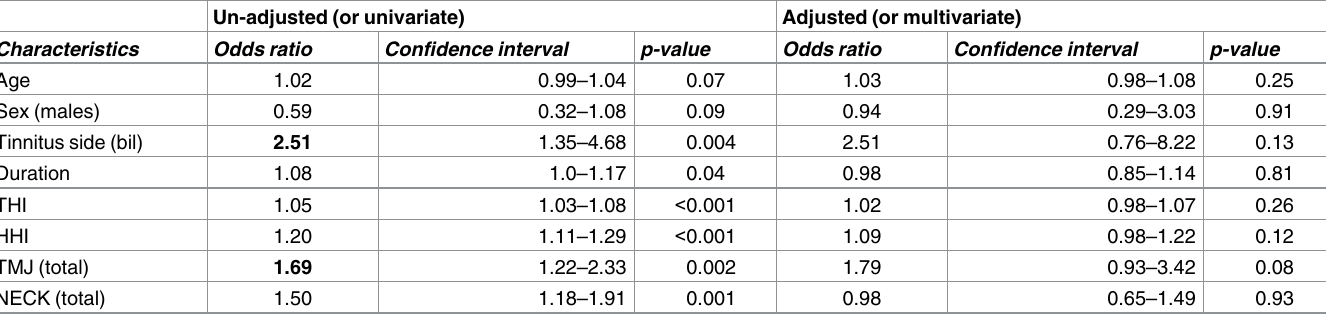
Table 3. Tinnitus, demographic and somatic disorder history characteristics among ST+HY